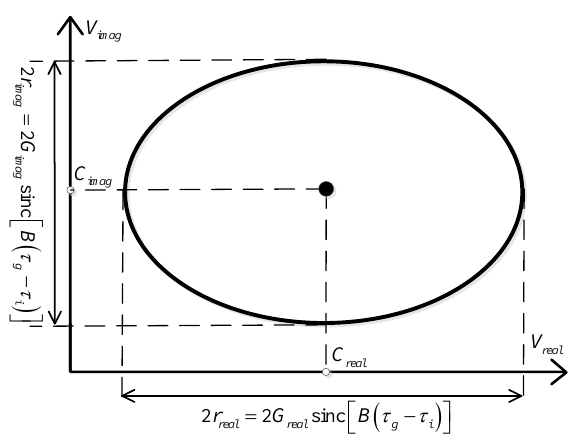
Figure 4. The output correlation circle of a complex correlator.